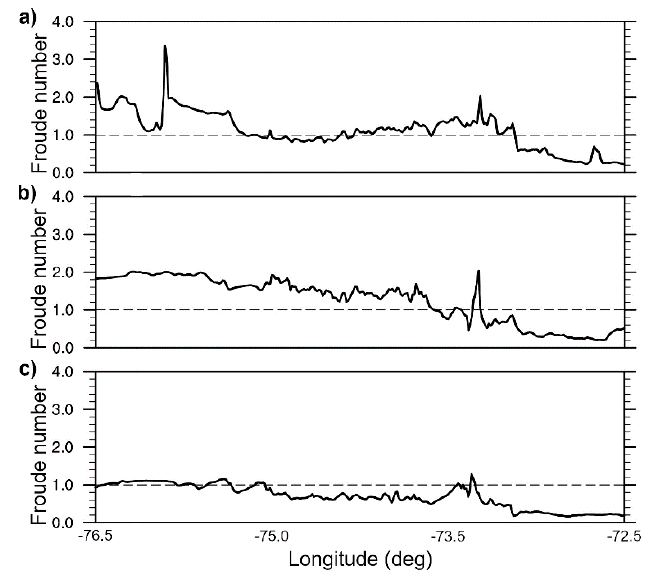
Figure 13. Froude number along the cross section for ( a ) supercritical case, ( b ) transition case and ( c ) subcritical case. The horizontal black line indicates Fr = 1.0. Data ( U and N ) are derived from WRF.